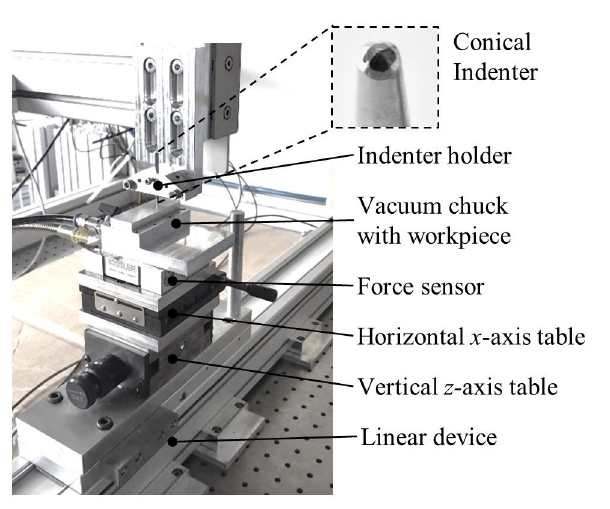
Figure 2. Single grit scratch test setup.